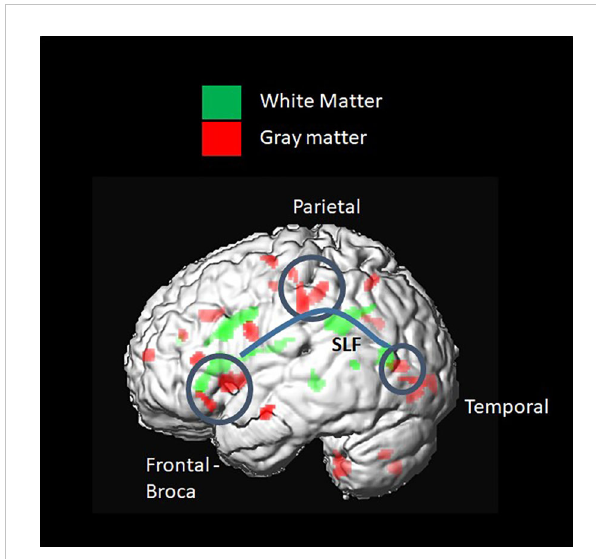
FIGURE 6 Voxel-based group comparison revealed a higher grey matter (GM) index in the type 1 diabetes (T1D) group. This included brain regions connected by white-matter (WM) fi ber tracts, such as the SLF and corona radiata. A higher GM probability index was found in the frontal inferior triangular and operculum regions, known as Wernicke, and in parietal regions, such as the inferior parietal and postcentral